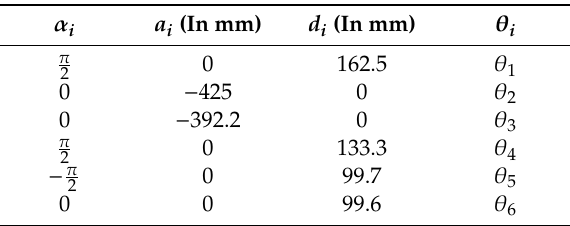
Figure 8. The idea of the feasible grasp using parallel gripper is presented using 2D example. ( a ) Part A (Green), and part B (Blue) are already assembled and part C (Red) is to be assembled. Part C contains three surfaces 𝑠 (cid:2869) , 𝑠 (cid:2870) , and 𝑠 (cid:2871) which define a feasible grasp for parallel grasping as defined in Section 3.1. The surfaces for feasible grasp are exposed in initial pose (in ( a )) as well as final pose (in ( b )) pose of the part C. Table 1. DH parameters of UR5e robot manipulator. 𝜶 𝒊